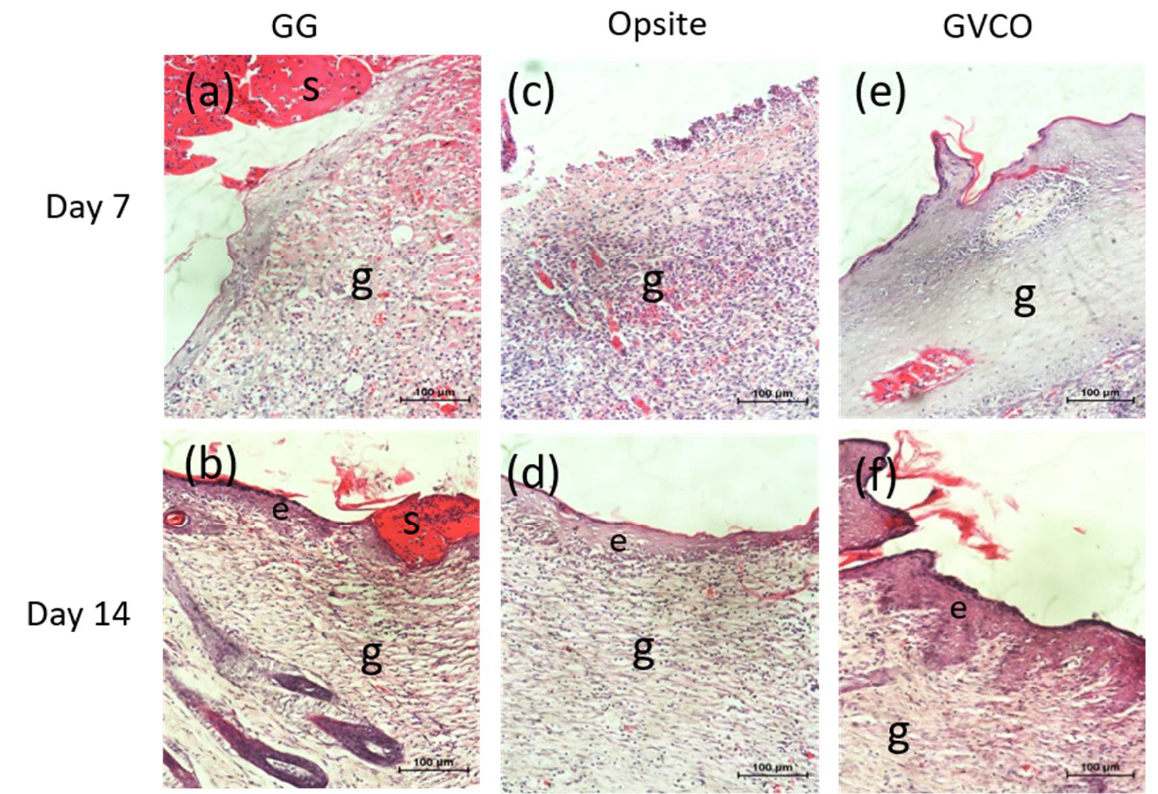
Figure 8. Representative images of the histological evaluation section on day 7 and 14 post-wound, stained with H & E ( a , b ) GG, ( c , d ) Opsite, and ( e , f ) GVCO80 hydrogel. Note: e = epidermis, g = granulation, s= scab; 20x magnification. The bar on the micrograph represents 100 µm.